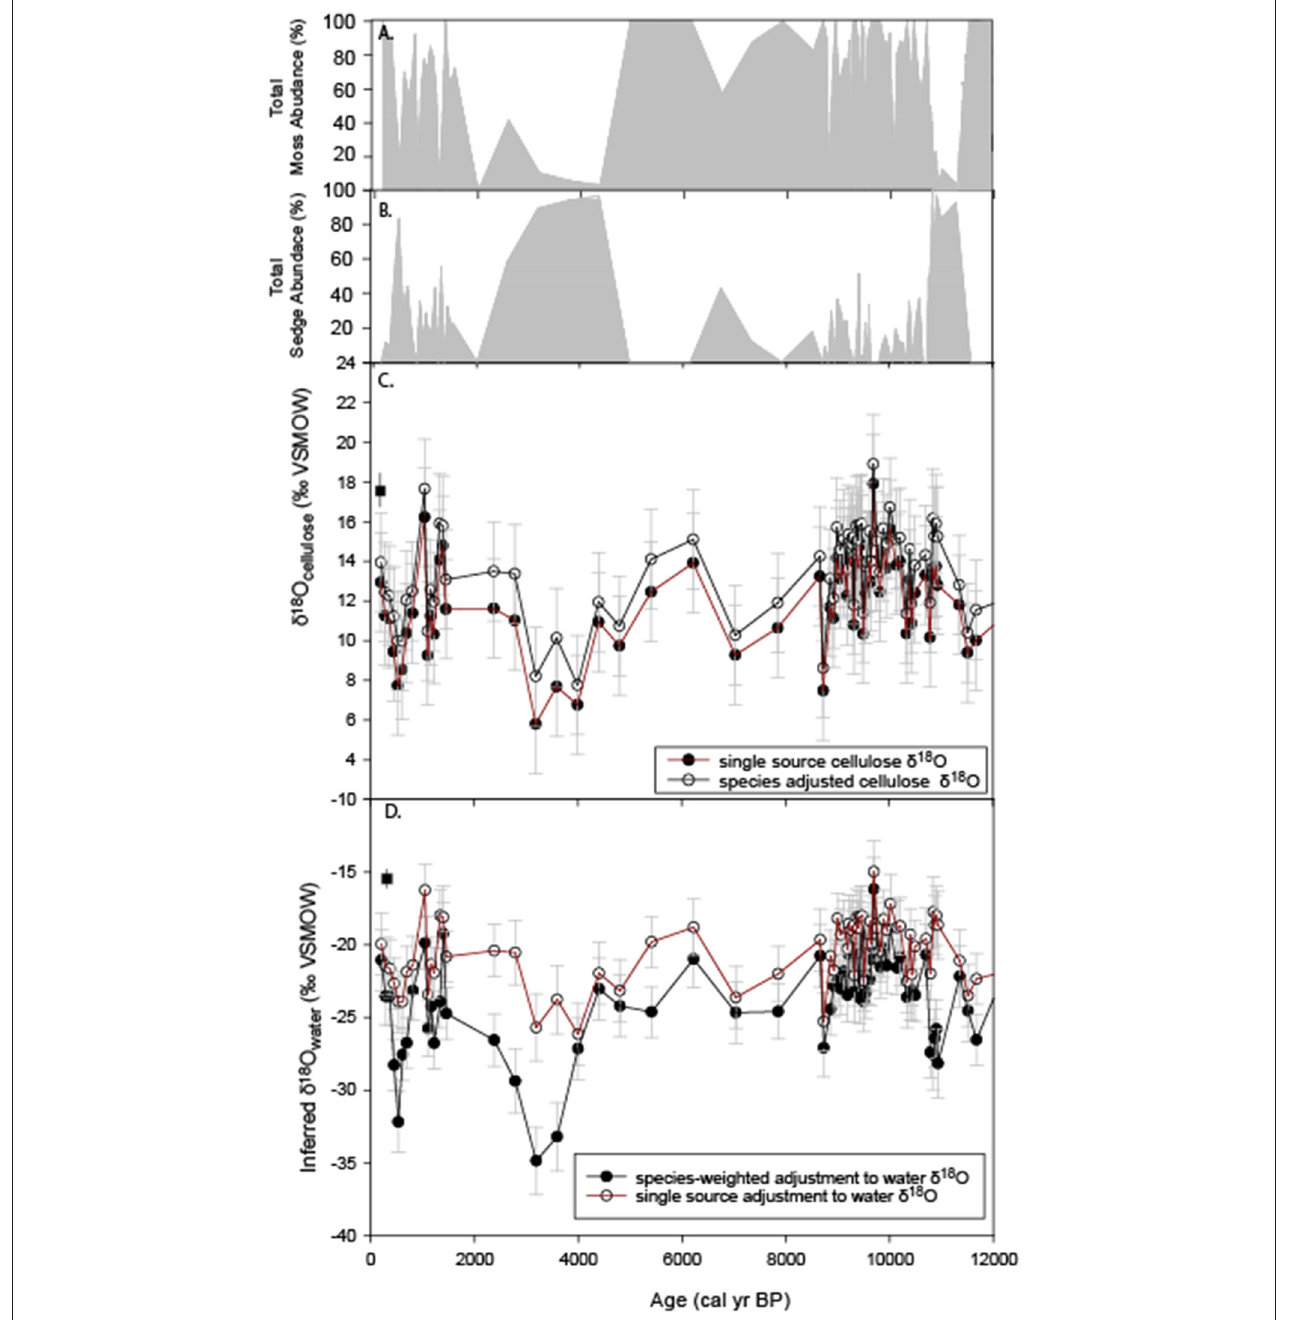
FIGURE 6 | Re-analysis of HTF peat δ 18 O record of Jones et al. (2014). (A) percent abundance of moss macrofossils ( Sphagnum + brown mosses), (B) percent abundance of Carex spp. macrofossils, (C) The original bulk δ 18 O cellulose values (red) and species adjusted values determined by this study (black square), (D) Peat-inferred water δ 18 O values using a constant cellulose fractionation offset of − 33 ‰ for bulk peat (red) and variable offsets depending on relative abundance of moss and Carex spp. macrofossils (black). The average modern water δ 18 O value determined by this study for year 2014 is the black square at 0 cal yr